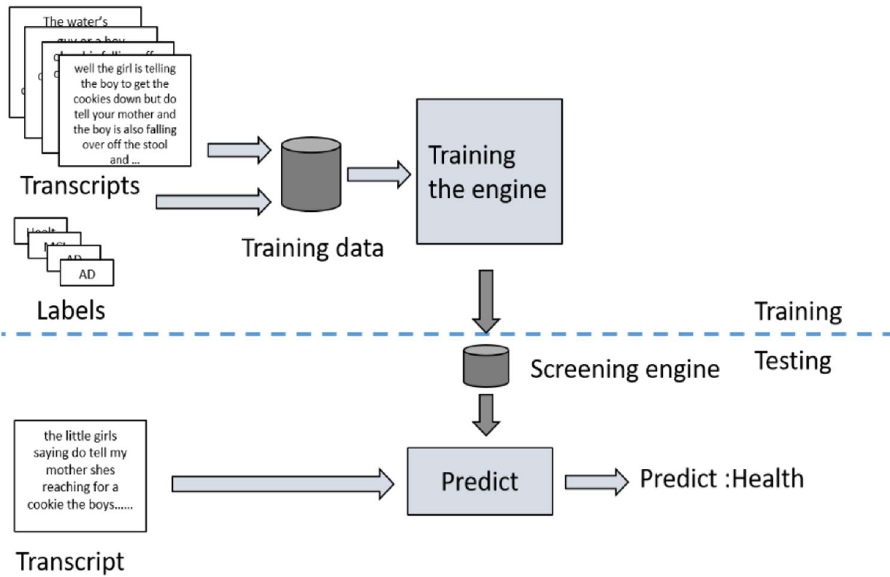
Figure 2. Overview of the proposed screening